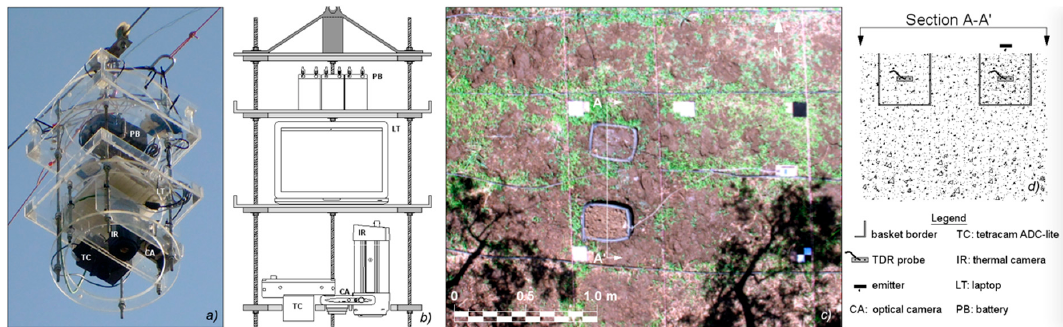
Figure 1. Image of the platform ( a ) and its schematic view showing the transported devices ( b ). Target of